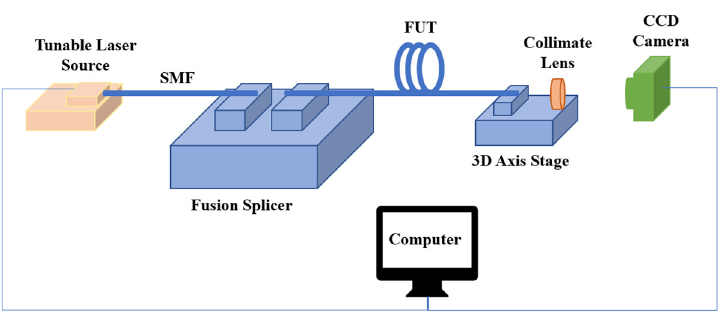
Figure 4. The few-mode fiber characterization system based on the S 2 technique.